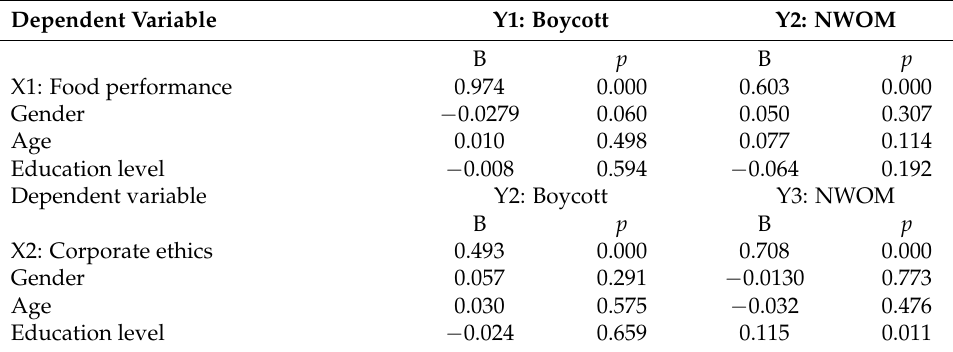
Table 5. Regression coefficient and t value of each main effect